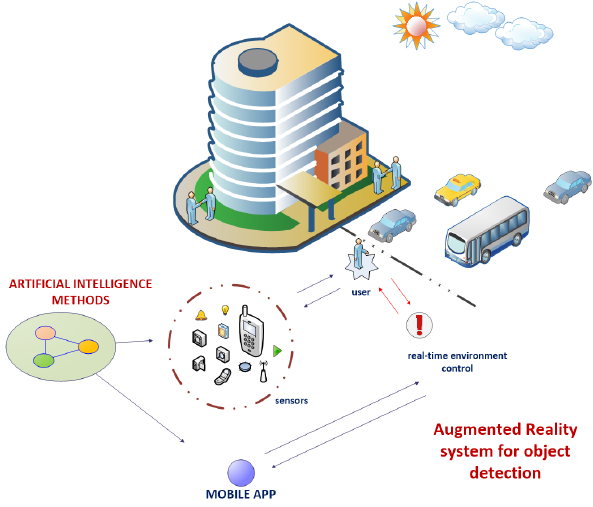
Figure 2. Sample presentation of the idea for an augmented reality detection system which by the use of proposed deep learning techniques evaluates readings from sensors in real